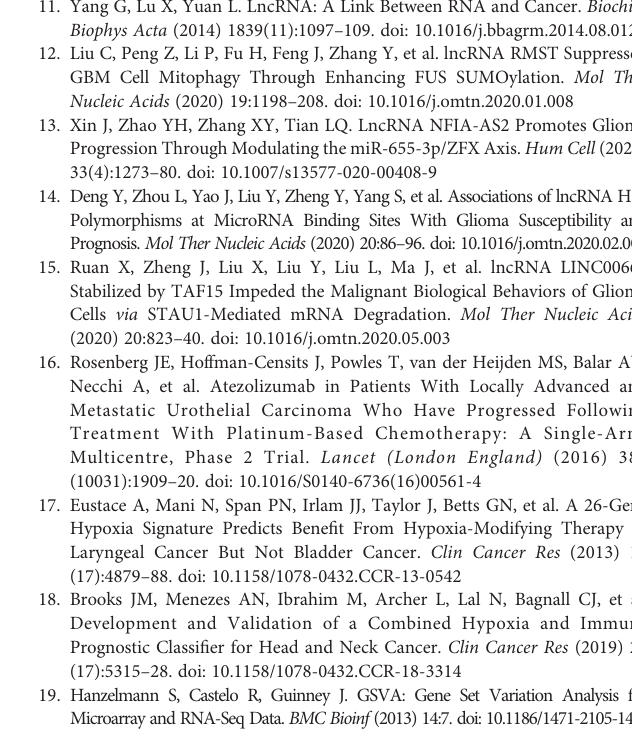
Supplementary Figure S1 | Kaplan-Meier analysis of randomly selected eight HRLs in LGG patients. Supplementary Figure S2 | The correlation between risk score and hypoxia- related genes. Supplementary Figure S3 | Volcano plot of differentially expressed genes. (A, B) Differentially expressed genes between high-risk and low-risk groups in the TCGA (A) and CGGA (B) datasets. (C, D) Differentially expressed genes between high or low expression of LINC00941 (C) and BASP1-AS1 (D) groups. Supplementary Figure S4 | Kaplan-Meier analysis of GNAI1 and PGAM1 in TCGA